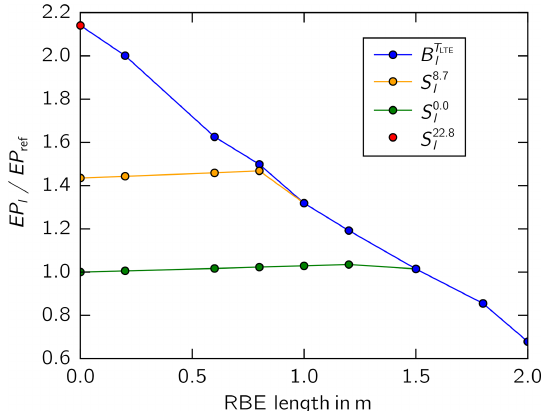
Figure 14. Relative energy production increase as function of blade length. Three scenarios